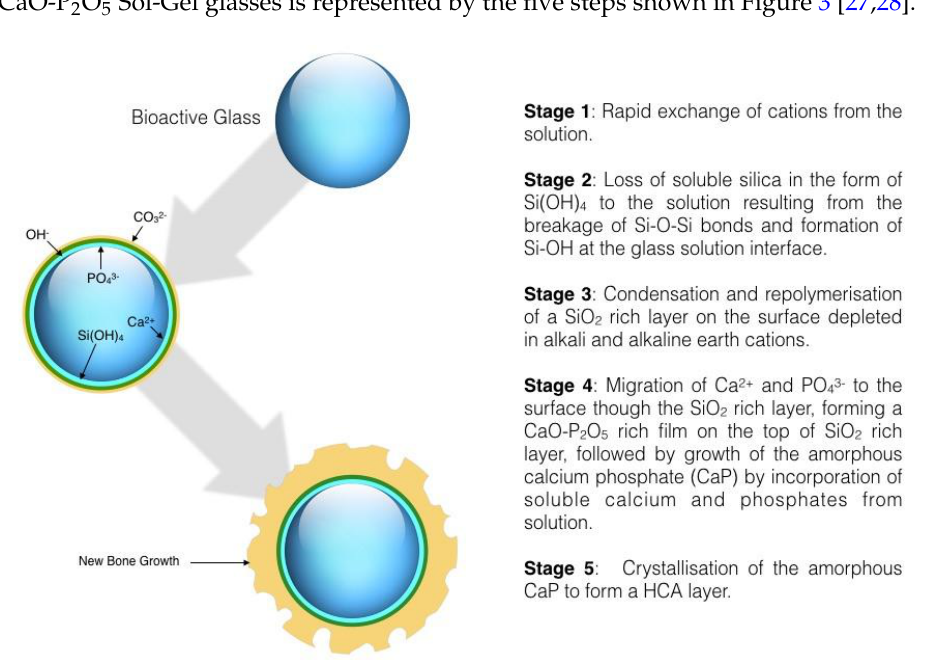
Figure 3. Bioactive glass surface reactions.